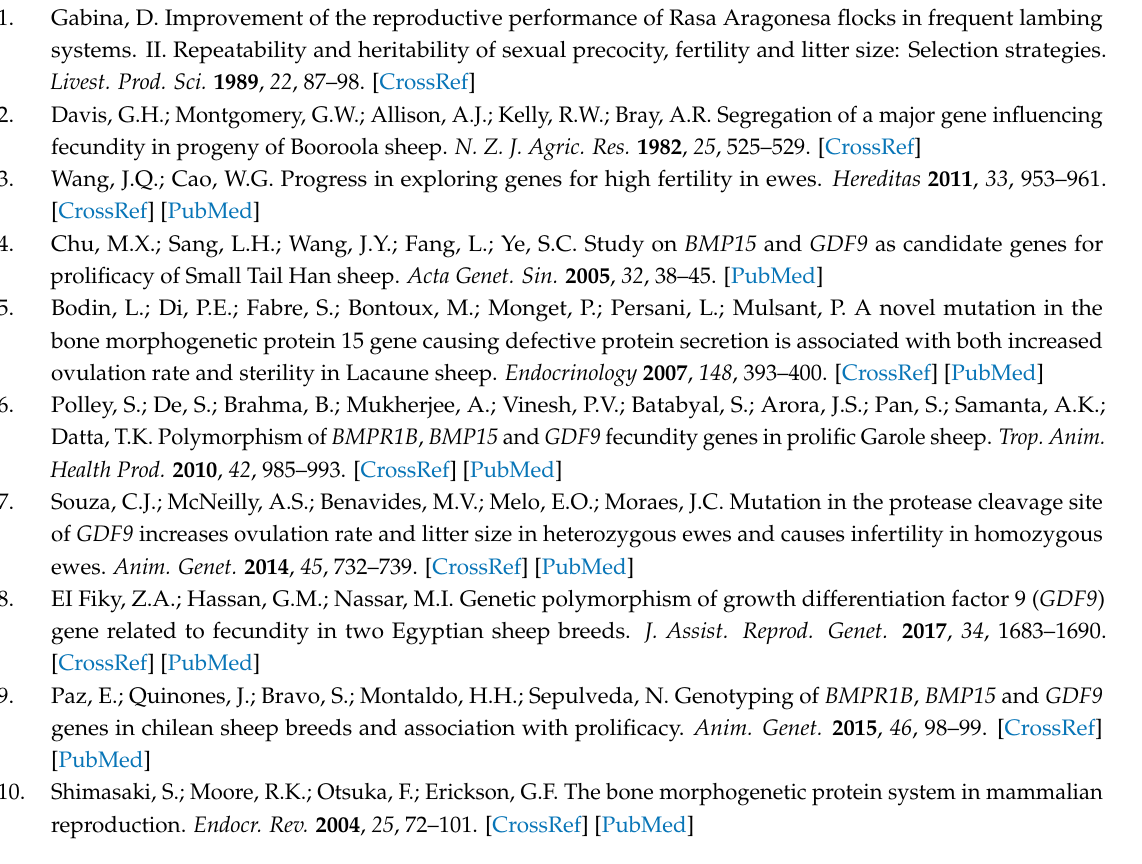
Supplementary File 1: Standard Curve of target